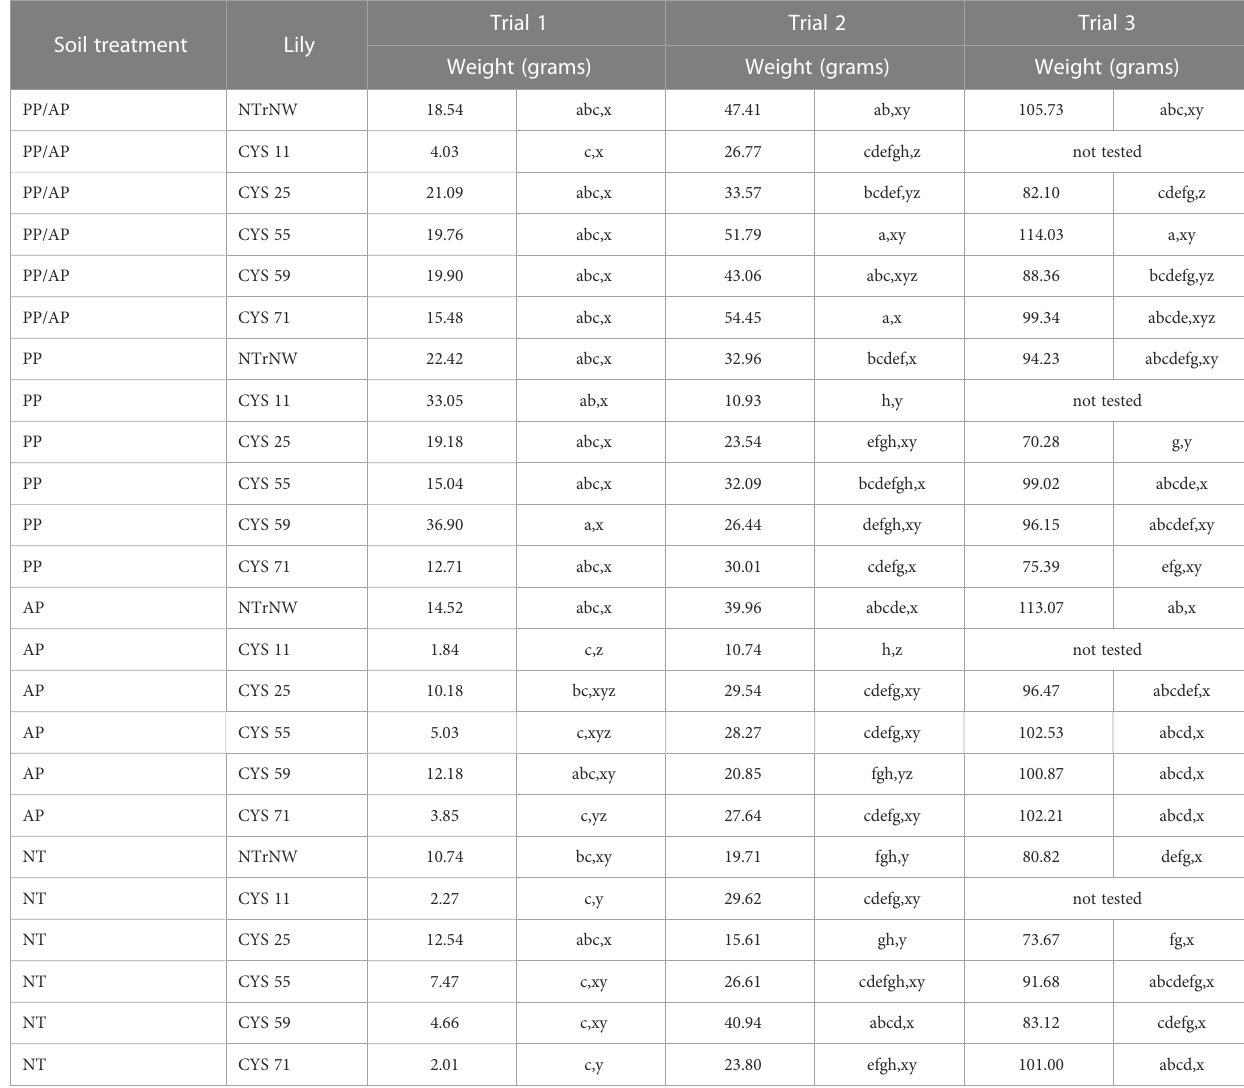
TABLE 2 Size of transformed and non-transformed plants (Trial 1) and bulbs at harvest (Trials 2 and 3) in fi eld trials conducted at the Easter Lily Research Foundation Research Station in Brookings, OR, USA in soil naturally infested with lesion nematode ( Pratylenchus penetrans ).